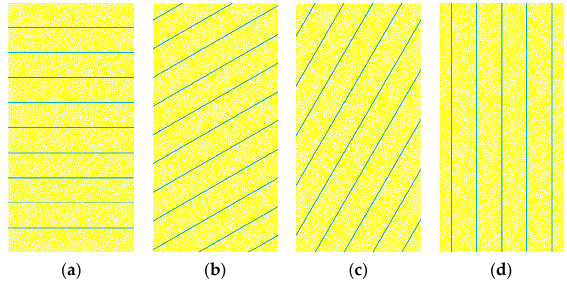
Figure 5. Numerical models for the shale samples with different oriented weak planes. ( a ) β = 0°; ( b ) β = 30°; ( c ) β = 60°; and ( d ) β = 90°.